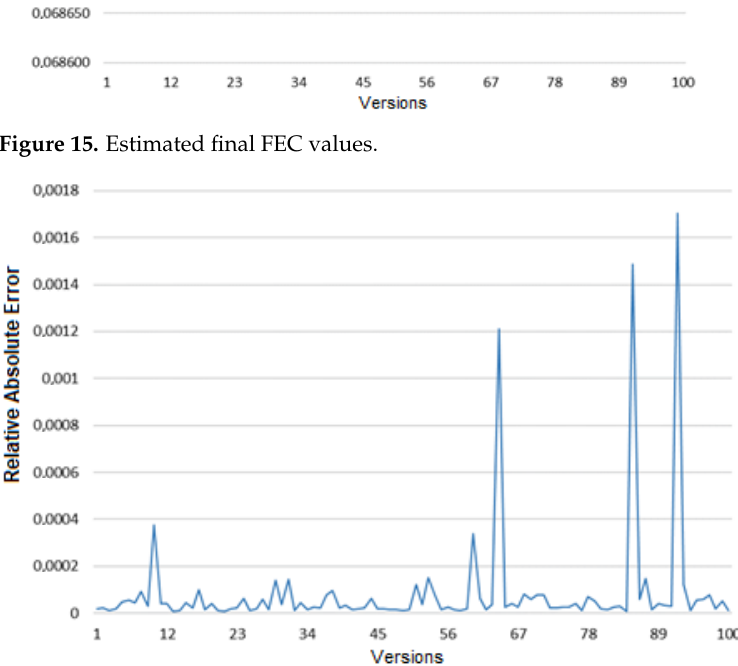
Figure 15. Estimated final FEC values.